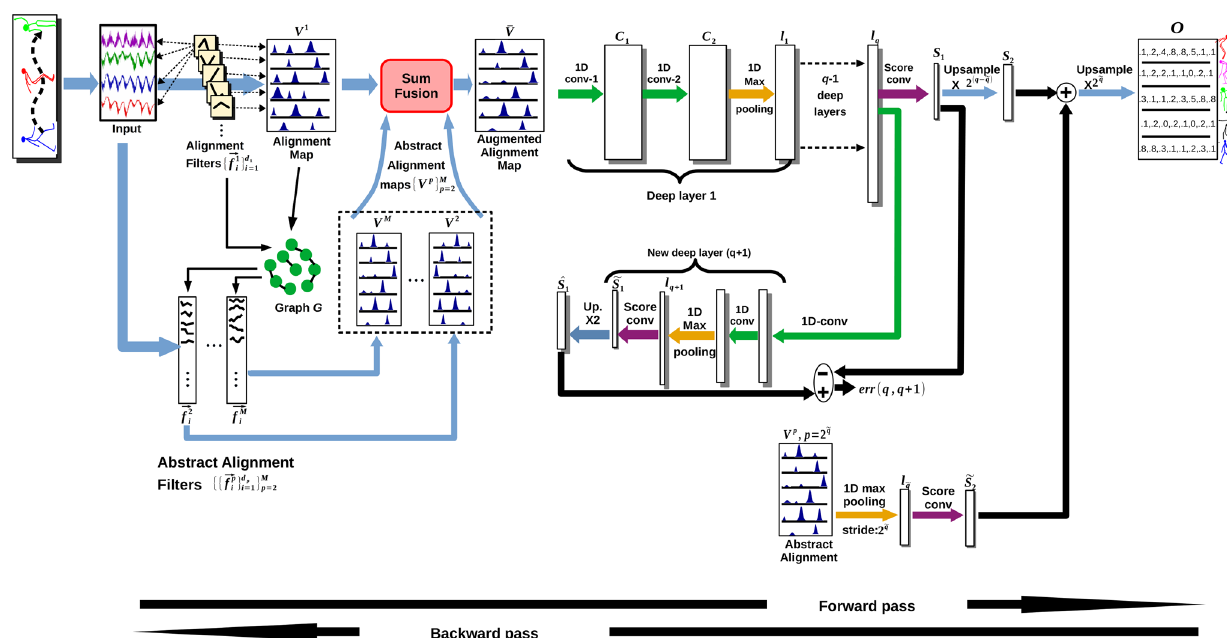
Fig. 11 Detailed description of the DACNN framework including all of its constituents (better to be seen in